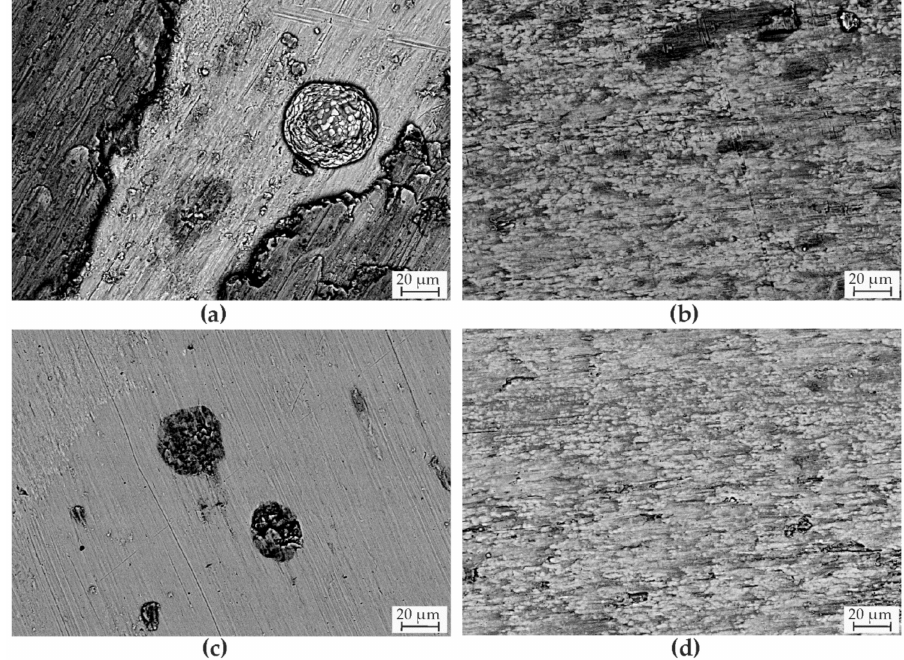
Figure 6. Surfaces (SEM, BSD) of the EHEA Al 0.3 CoCrFeNiNb 0.5 after ball-on-disk testing of ( a ) un- treated and ( b ) heat-treated SPS bulk material as well as ( c ) untreated and ( d ) heat-treated LMD coating. Plastic deformation can be observed for all